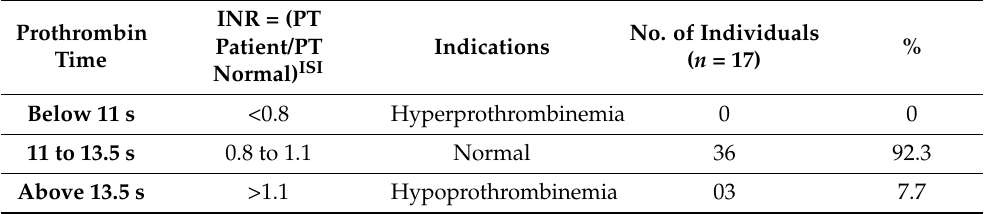
Table 6. The table shows the prothrombin time test for the PCR-positive individuals ( n = 39), which was calculated under ISI value 1.4 Merck Company for its reagents.